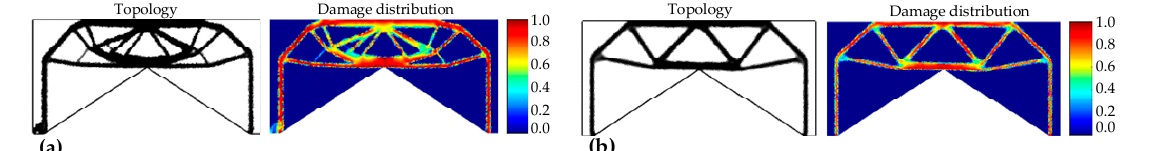
Figure 13. Optimal topology and damage distribution for a portal frame: ( a ) P-norm constraint ( f = 0.285), ( b ) local constraint ( f = 0.217).